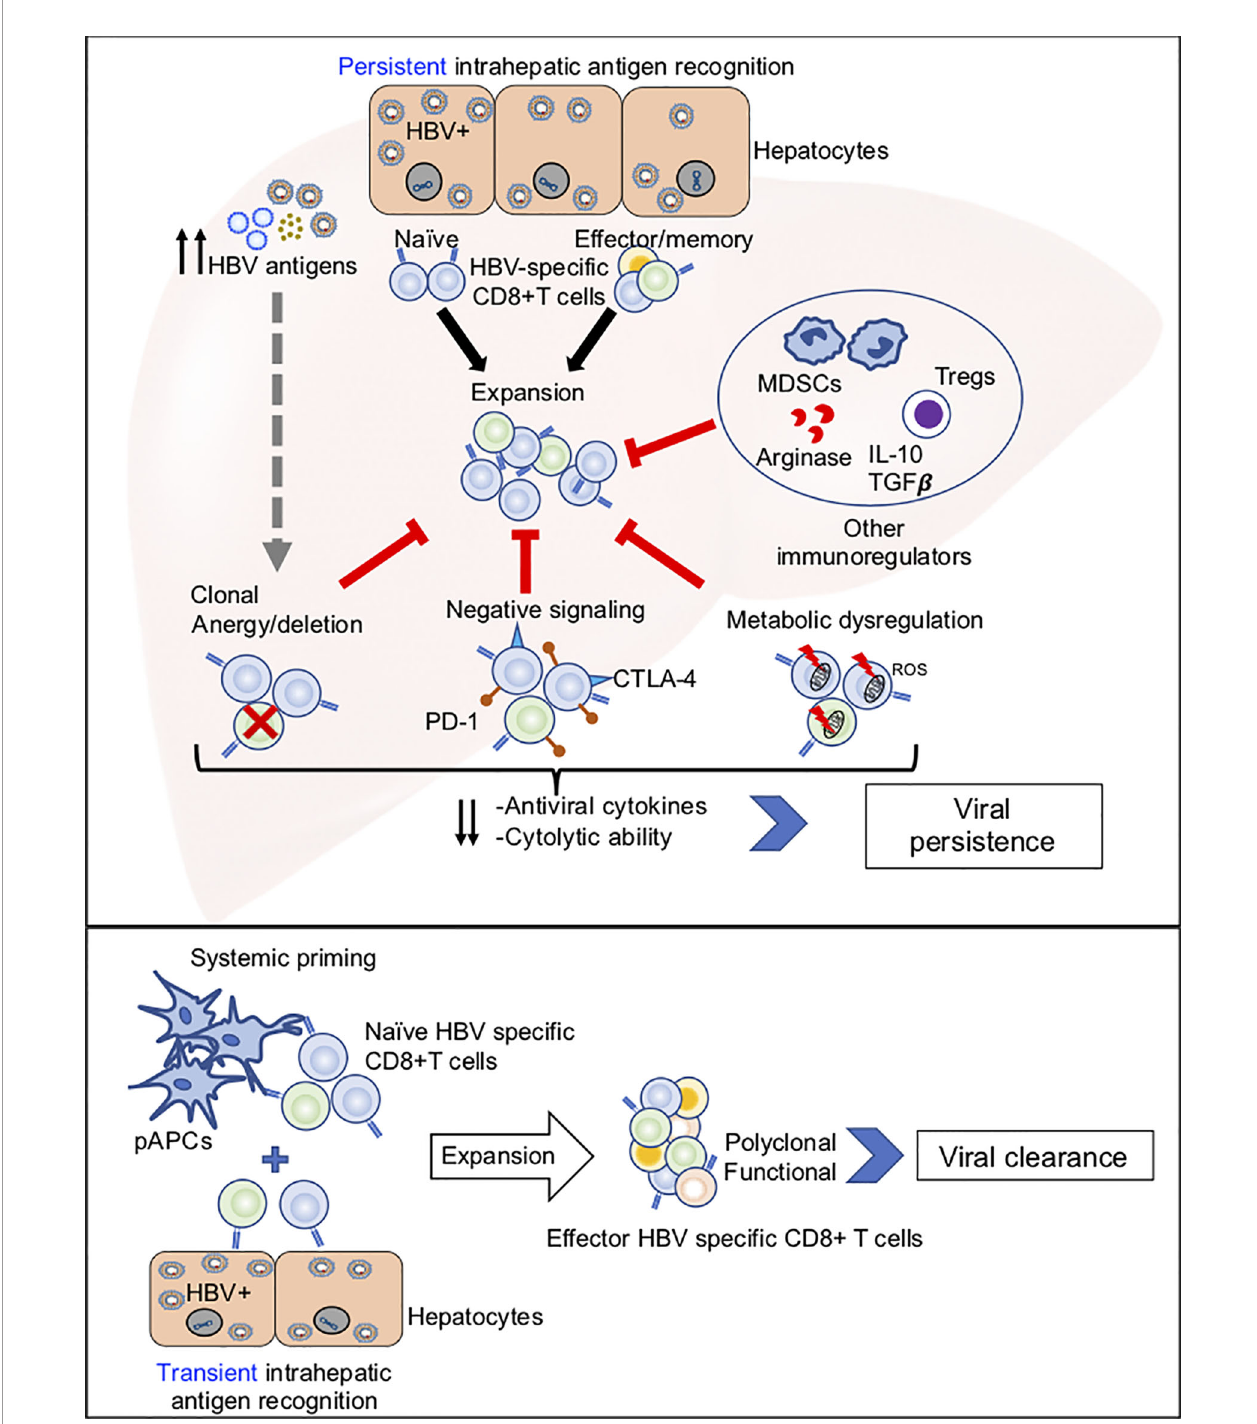
FIGURE 1 | Potential mechanisms of HBV-speci fi c CD8+ T cell dysfunction. Top panel: Illustration of how persistent antigen recognition, predominantly by HBV infected hepatocytes, results in dysfunctional HBV-speci fi c CD8+ T cells that fail to clear infection. Bottom panel: Illustration of how systemic and hepatic antigen recognition may cooperatively trigger robust HBV-speci fi c CD8+ T cell responses that result in viral